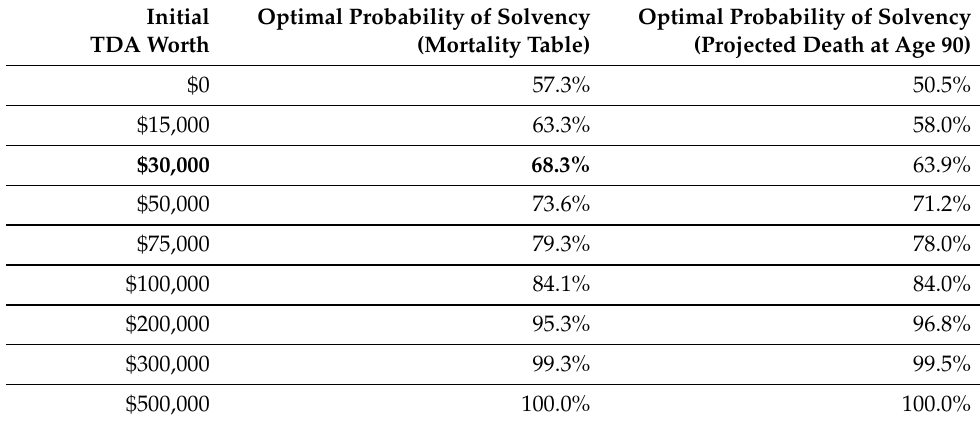
Table 11. The effect on Investor #1 of varying the initial worth of the TDA from its normal value (in bold).